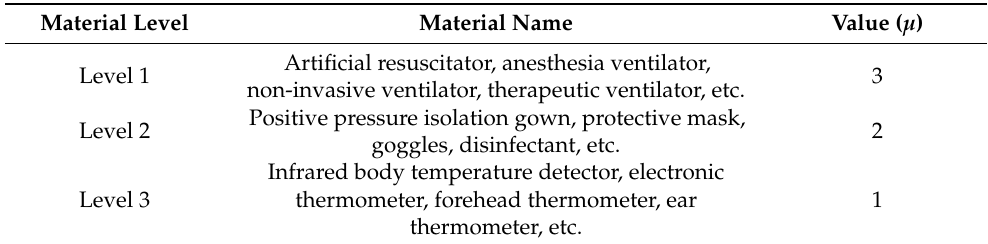
Table 4. Goods classification